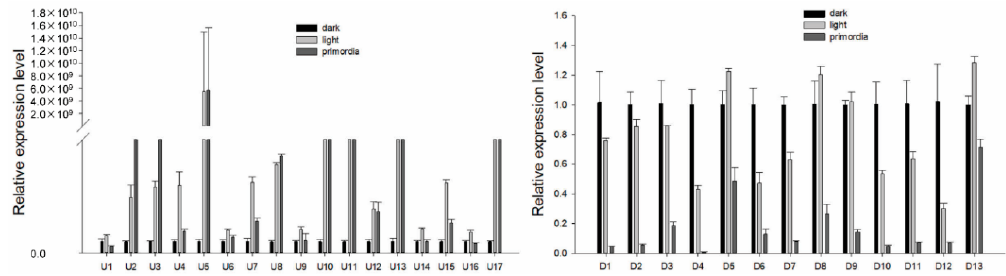
Figure 6. Relative expression levels of the DEGs. X axes are the gene codes of the DEGs, and Y axes are the relative expression levels of the DEGs. Data are presented as mean ± SD.